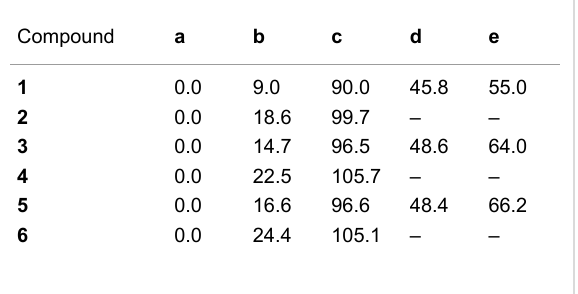
Table 1: Relative stabilities in kJ mol –1 of the different tautomers of compounds shown in Figure 1 and Figure 7.